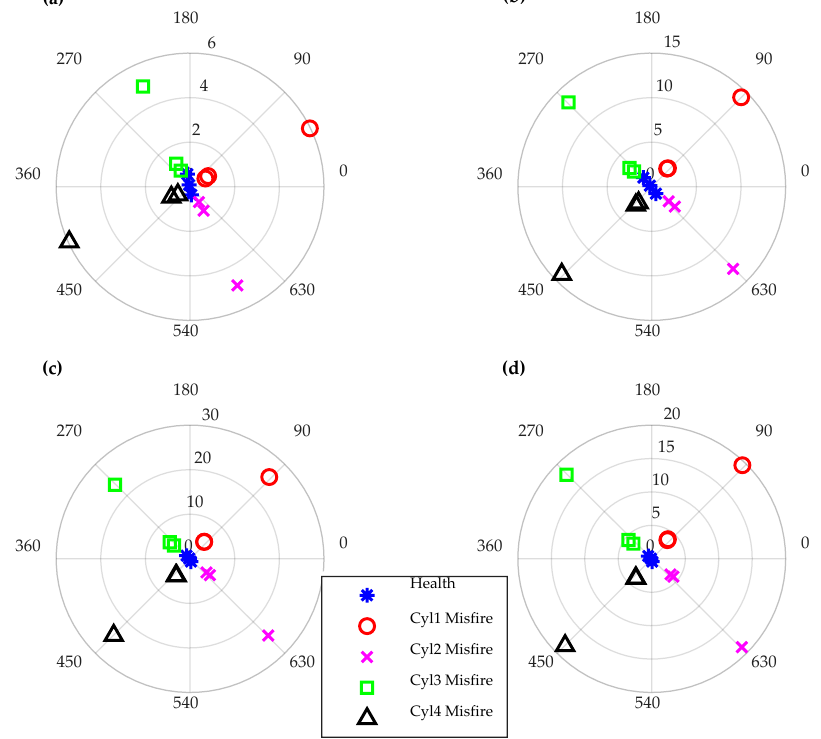
Figure 16. Polar plotting of fault indicators at 1600 rpm: ( a ) 0 Nm; ( b ) 105 Nm; ( c ) 210 Nm; ( d ) 315 Nm.